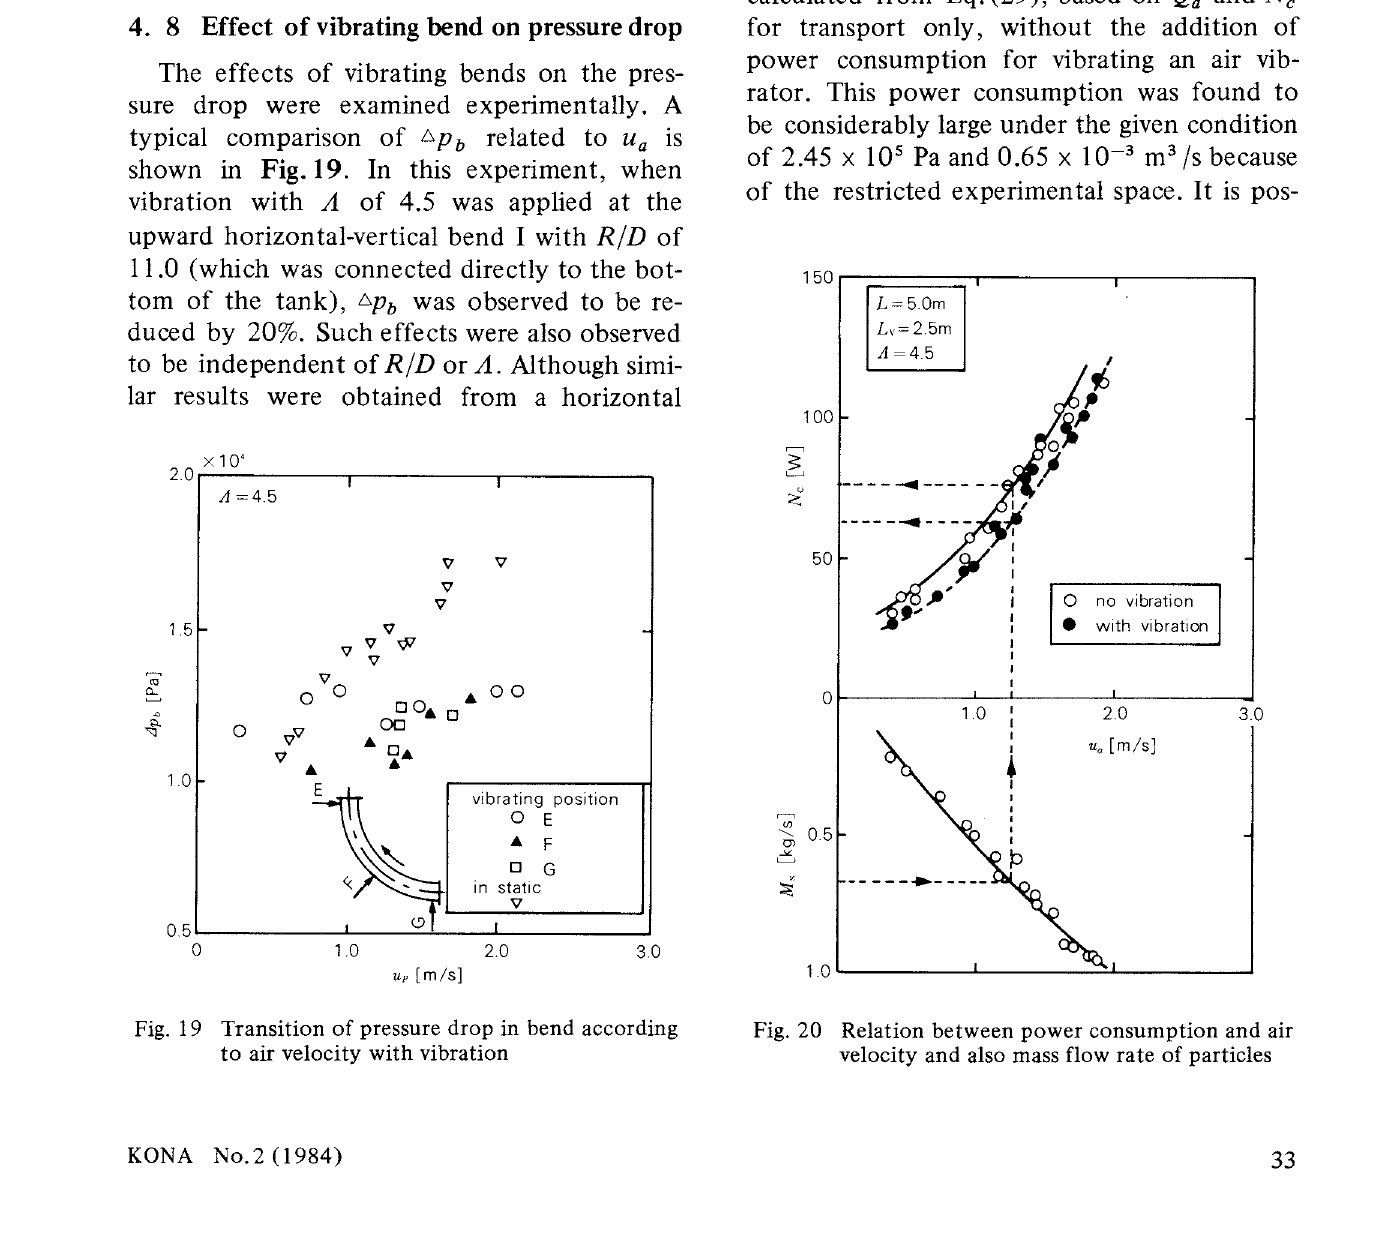
Fig. 20 Relation between power consumption and air velocity and also mass flow rate of